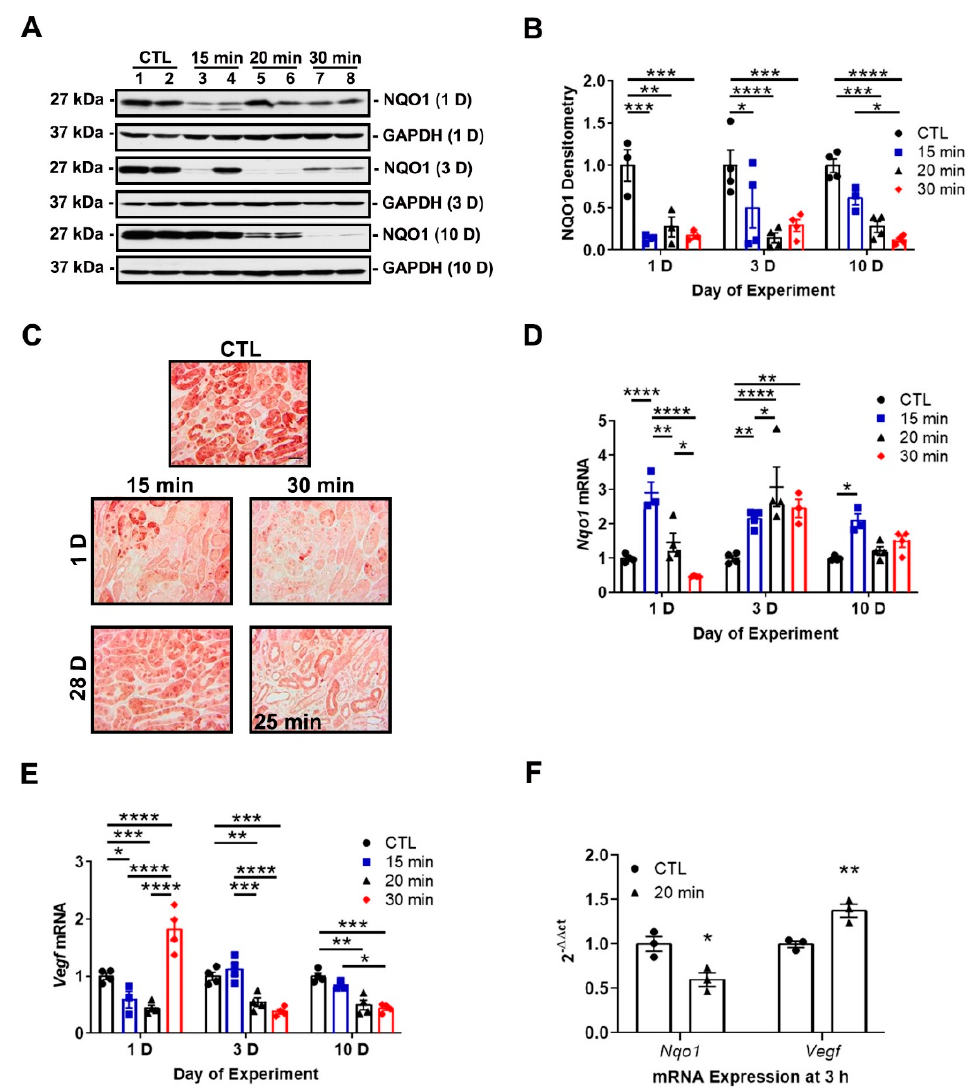
Figure 3. IRI severity determines NRF2 and HIF-1 α activity. ( A ) Representative immunoblots of NQO1 protein expression at days 1, 3, and 10. NQO1 expression decreases at day 1 in all groups but recovers by day 10 in the 15-min group. Notably, NQO1 expression declines by day 10 in the 30-min group. ( B ) Densitometry of NQO1 normalized to GAPDH. ( C ) Representative IHC images of NQO1 protein expression at days 1 and 28. A surrogate 25-min group is substituted for the 30-min group in which there was no survival at day 28. Renal tubular NQO1 expression decreases at day 1 in both groups but recovers by day 28 in the 15-min group. Bar = 50 µm. ( D , E ) Nqo1 and Vegf mRNA expression at days 1, 3, and 10. Sustained increases in Nqo1 are induced by 15 min ischemia at all time points, while longer ischemia times lead to delayed and transient increases peaking at day 3. Vegf mRNA expression decreases in the 15- and 20-min groups but increases in the 30-min group at day 1. The 20- and 30-min groups show a sustained reduction in Vegf at days 3 and 10 compared to the control and 15-min groups. The contralateral kidney from the 15-min group is used as the control. ( F ) Nqo1 and Vegf mRNA expression at 3 h after reperfusion. Nqo1 decreases while Vegf increases in the 20-min group. Bars are mean ± S.E.M. Two-way ANOVA or unpaired Student’s t-test, as appropriate. * p < 0.05, ** p < 0.01, *** p < 0.001, and **** p <